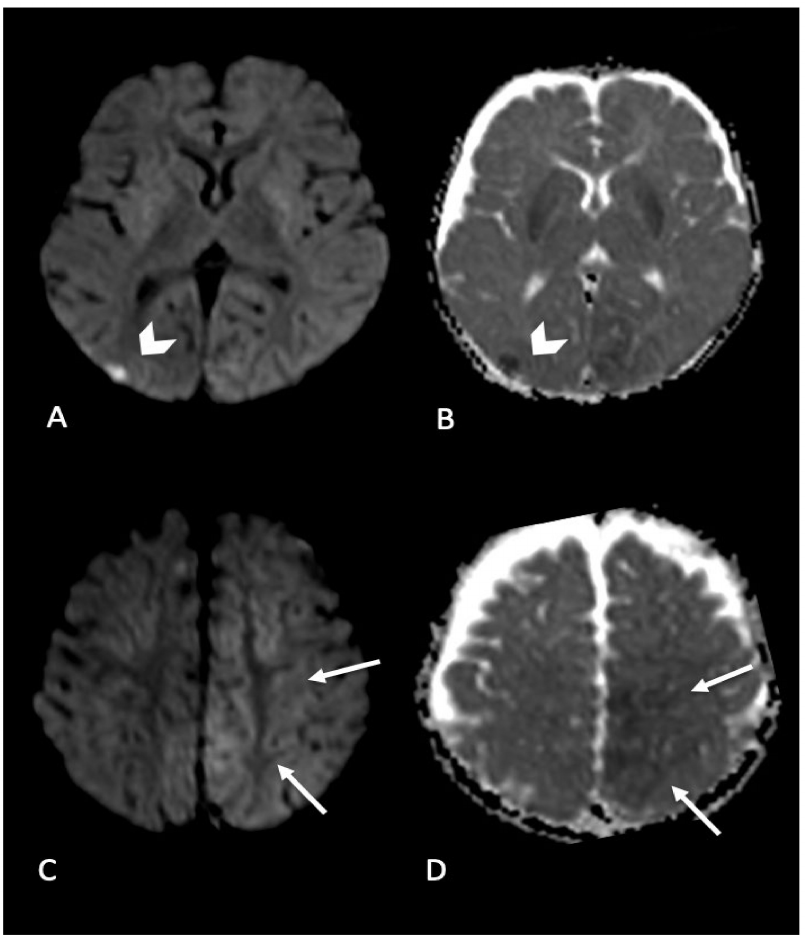
Figure 4. Infant found with right side focal seizures with secondary generalization. Bruises on the right ear, retinal hemorrhages and subdural hemorrhages. MRI performed in the emergency department showed bilateral parenchymal injury. In particular, in ( A , B ) (axial DWI and ADC map) diffusion weighted imaging revealed focal area of restricted diffusion in right occipital cortex (arrow’s head); ( C , D ) (axial DWI and ADC map) showed areas of restricted diffusion in left mesial parietal cortex